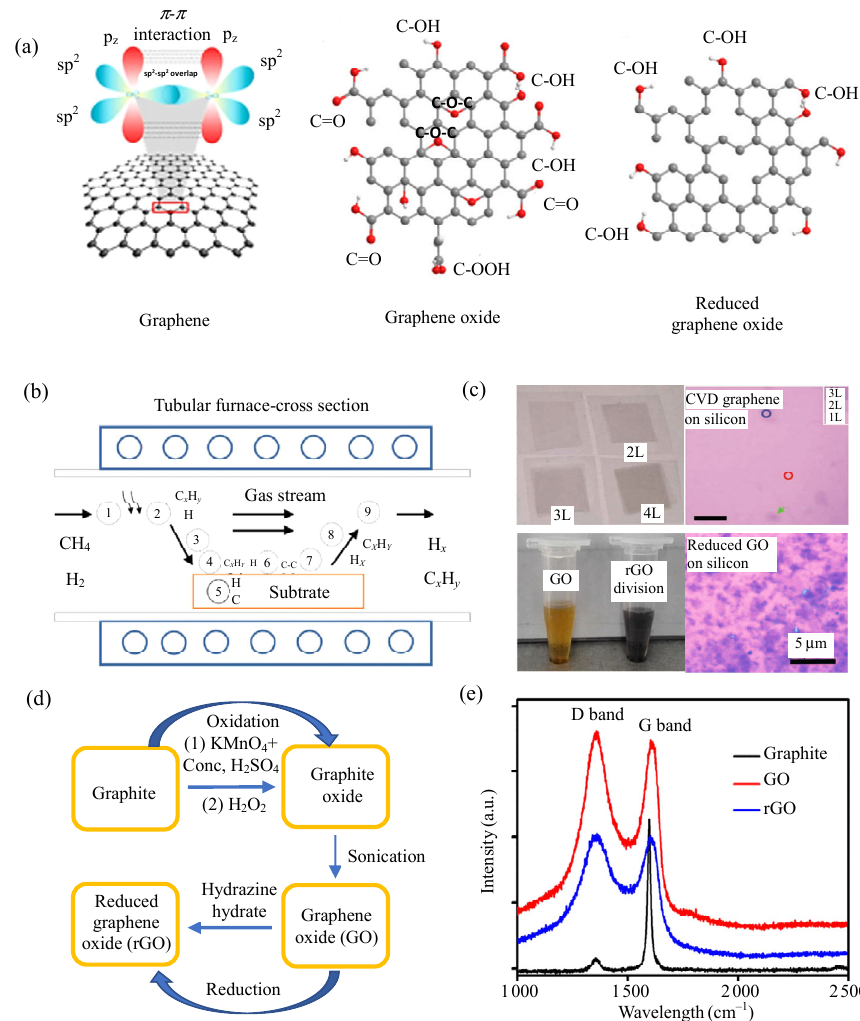
Fig. 2 Synthesis of graphene and its derivatives: (a) structures of graphene-based materials [pristine graphene(left), GO(middle), and rGO(right)] [36], (b) illustration of the CVD method for growing graphene on the Cu substrate [41], (c) picture of graphene grown from CVD, and GO, rGO division, the deposition film on silicon substrate are also shown [26], (d) flow chart of GO and rGO preparation [40], and (e) measured Raman spectra of graphite, GO, and rGO